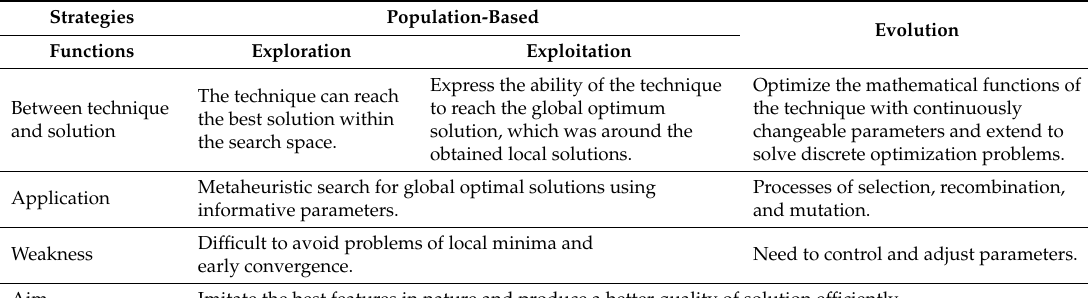
Table 4. Comparison of the use of optimization between population and evolution strategies.